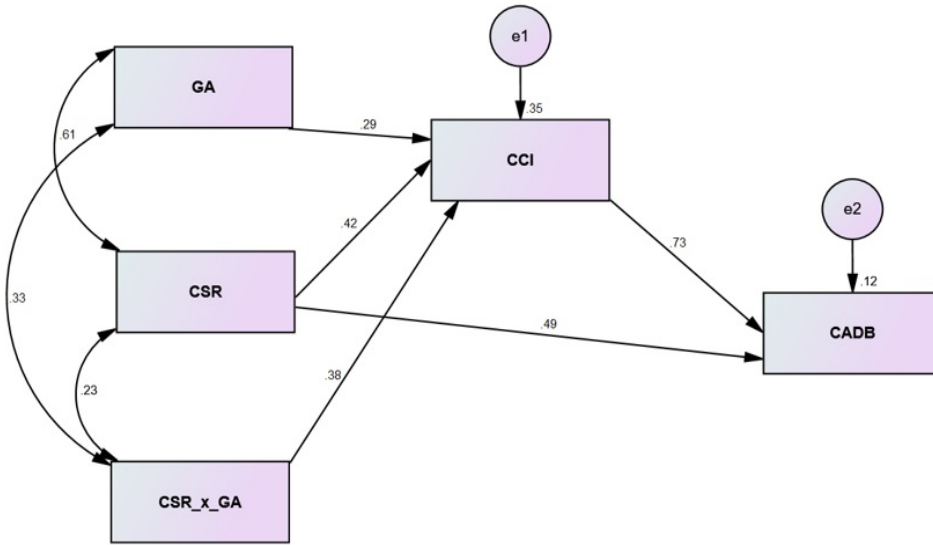
Figure 3. Structural model.